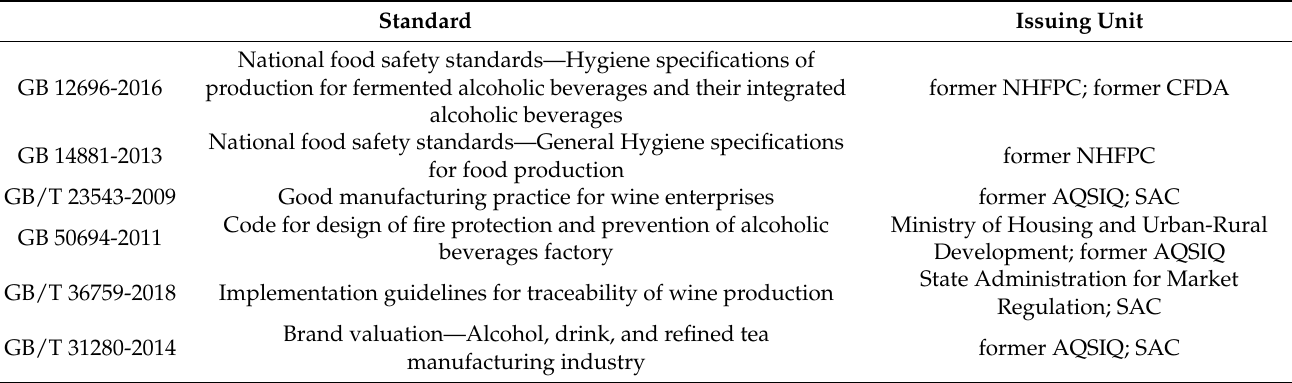
Table 6 lists some national standards related to Chinese wine companies. Table 6. National standards related to Chinese wine